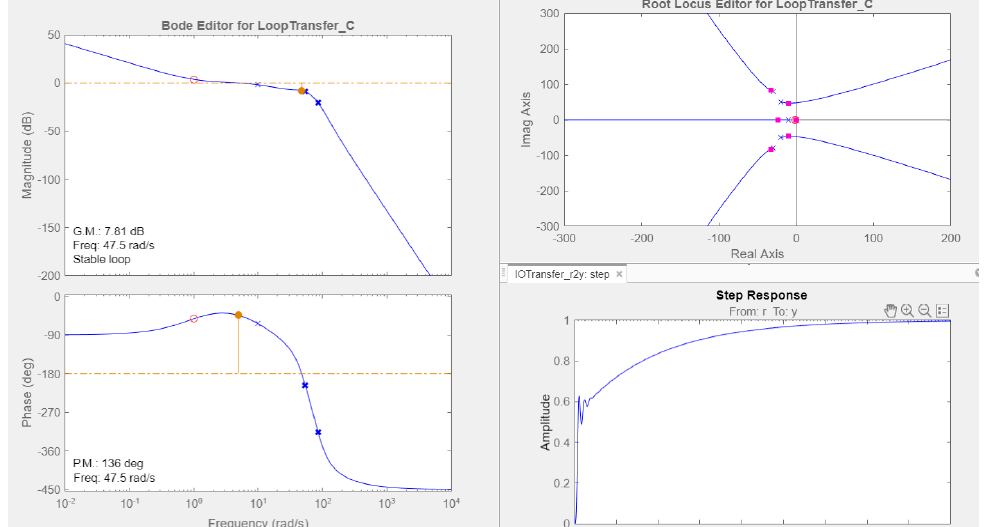
Figure 12. Using SISOTOOL toolbox for tuning the PI controller in Mode 1.